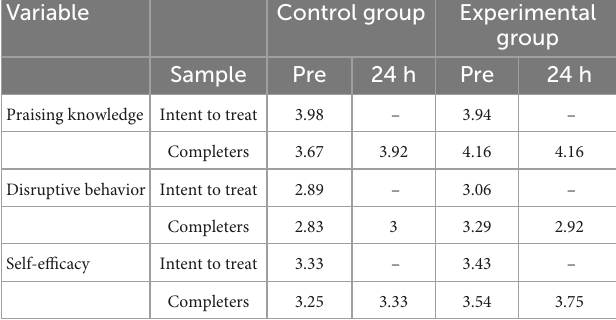
TABLE 5 Pre-24 h descriptive statistics of outcome